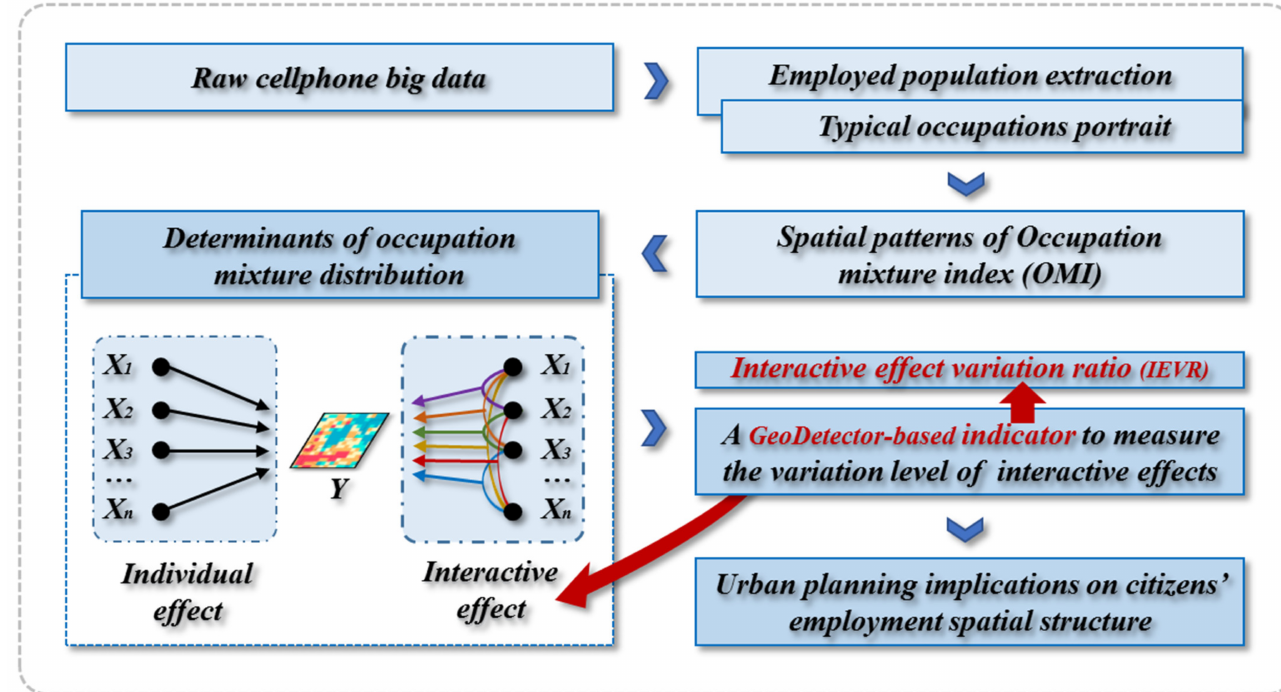
Figure 1. The framework of the